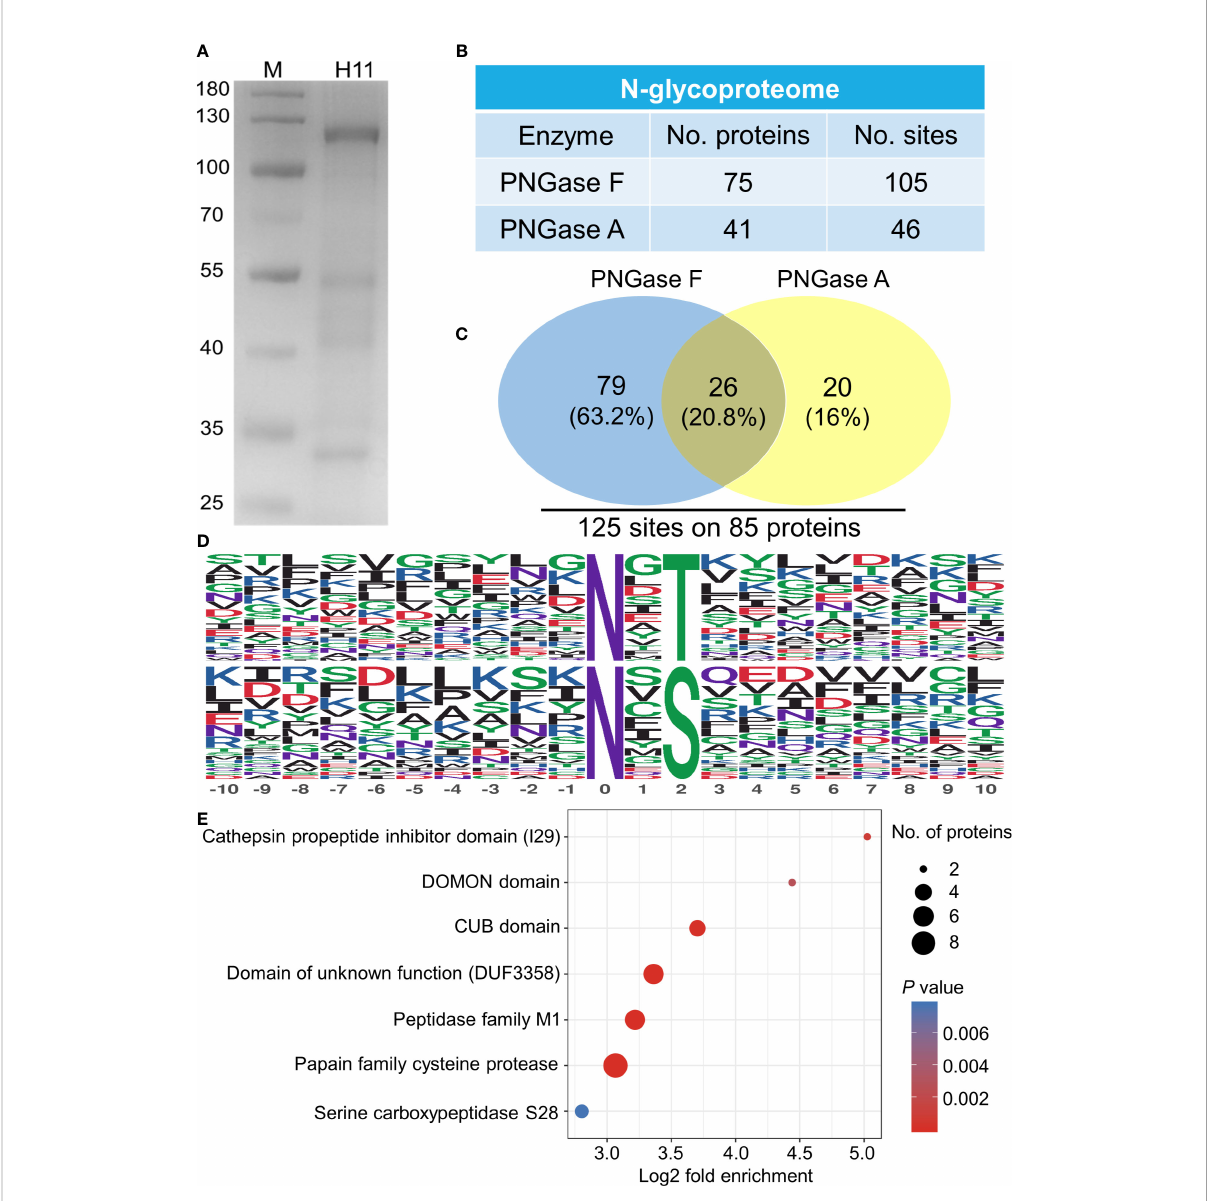
FIGURE 1 N-glycoproteome analysis of Haemonchus contortus H11. (A) SDS-PAGE analysis of concanavalin A lectin-puri fi ed H. contortus native H11 (10 µg). (B) N-glycoproteome identi fi ed in native H11. H11 sample was sequentially digested with PNGase F and PNGase A, and their N- glycoproteins and N-glycosylation sites were identi fi ed by liquid chromatography-tandem mass spectrometry (LC-MS/MS). Data are derived from two independent experiments (cf. Supplementary Table 1). (C) Comparison between the PNGase F- and PNGase A-released N- glycosylation sites and total numbers of N-glycoproteins and N-glycosylation sites are shown. (D) Conserved sequence motifs analyses around glycosylated asparagine residues ( − 10 to +10; N, asparagine; T, threonine; S, serine). (E) Domain enrichment analysis of the identi fi ed N- glycoproteins ( p < 0.05). Each domain is bubble-coded; red and blue represent the enrichment and depletion (Fisher ’ s exact test p value); size re fl ects the number of glycoproteins (cf. Supplementary Table